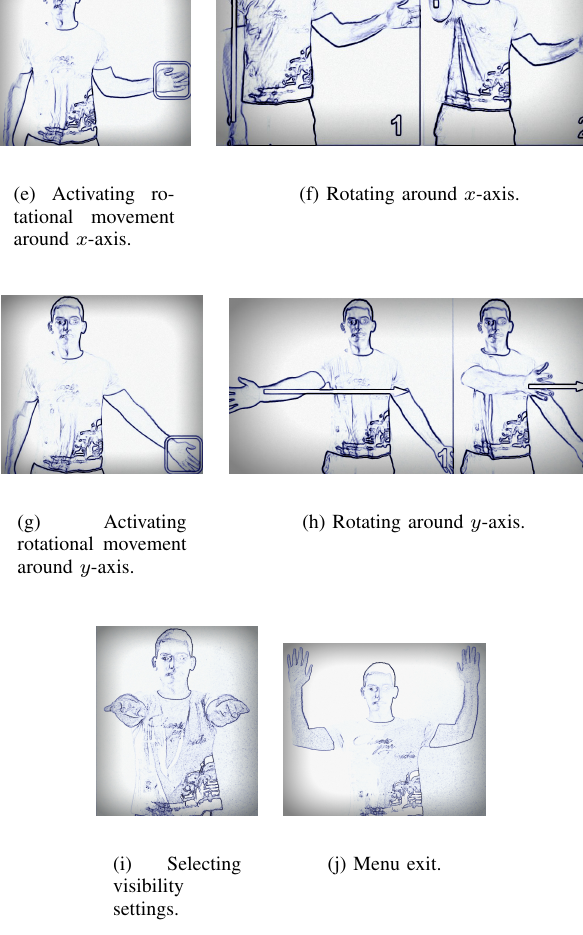
Fig. 12: In (a), (b), (c), (d), (e), (f), (g), (h) and in (a), (i), (j), respectively, hand gestures to control 3D models and the visibility settings